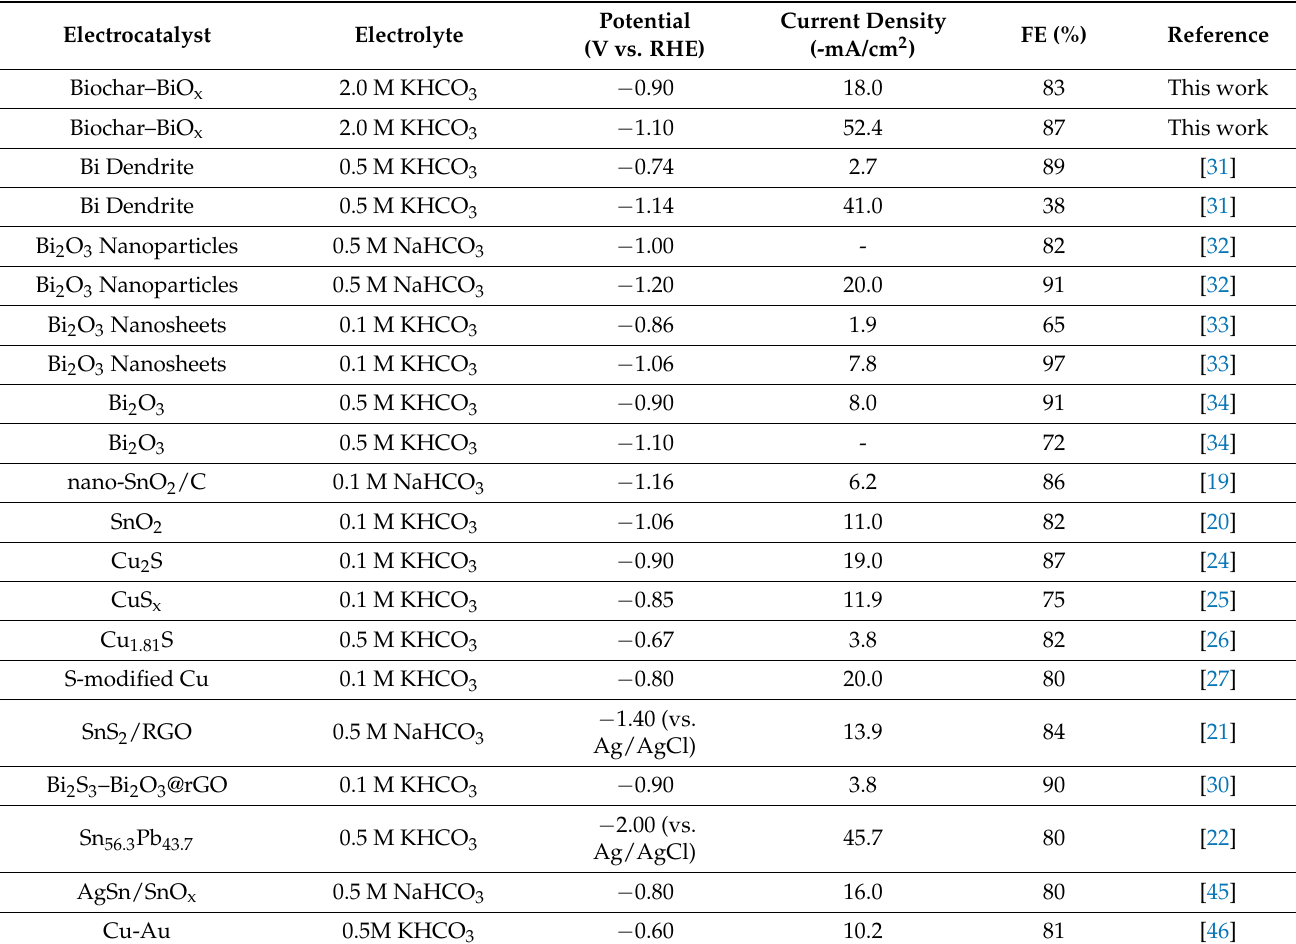
Table 2. Comparison of different HCOOH-selective electrocatalysts in liquid-phase CO 2 electrolysis. Electrocatalyst Electrolyte (V vs.